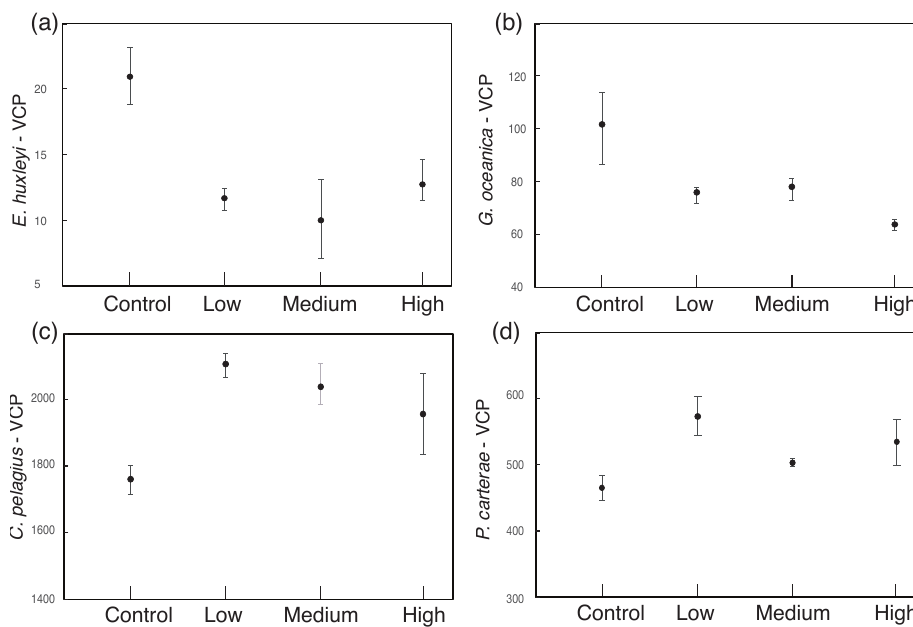
Figure 5. Average volume of the calcitic portion of the coccosphere (VCP). All measurements were done in triplicates; error bars denote standard deviation. If not visible, error bars are smaller than symbols measured for each replicate: (a) E. huxleyi; (b) G. oceanica ; (c) C. pelagicus ; (d) P. carterae. Note the different scales on the y